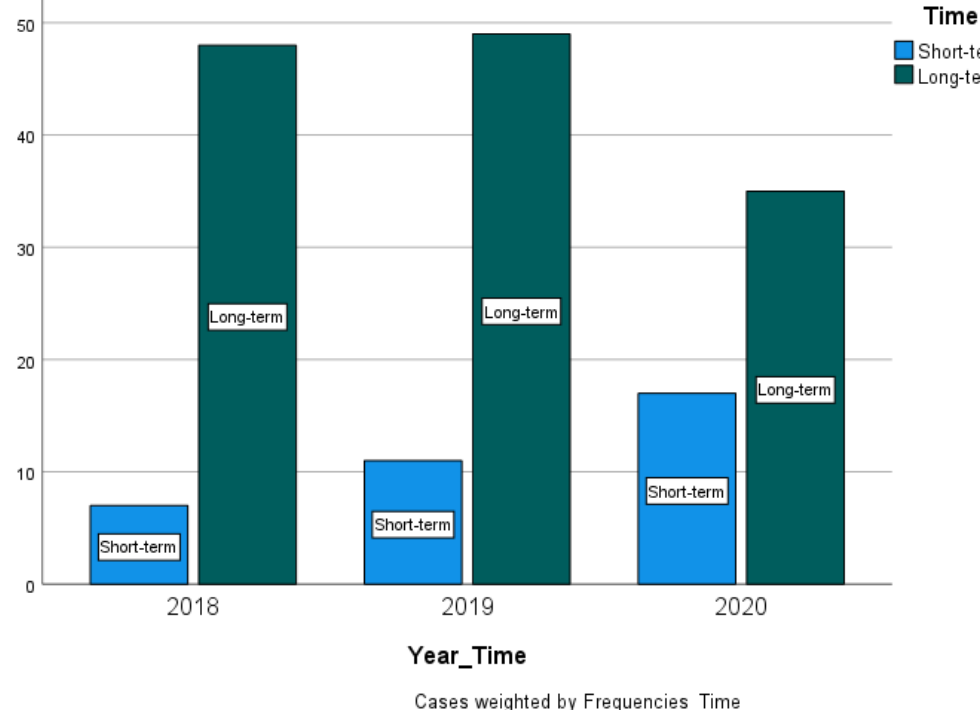
Figure 4: Time Orientation by